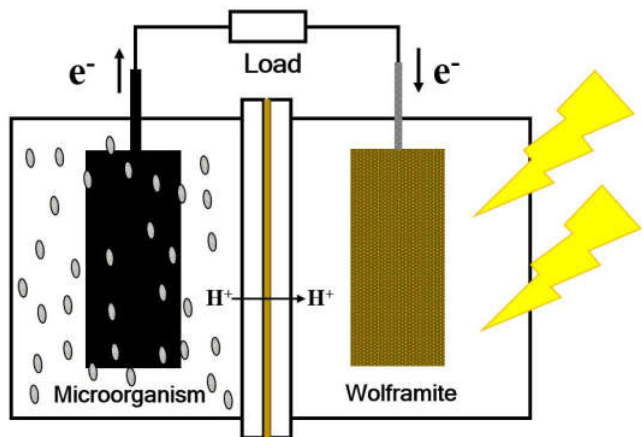
Figure 1. Schematic representation of the microbial fuel cell (MFC) with a natural wolframite-coated graphite cathode.